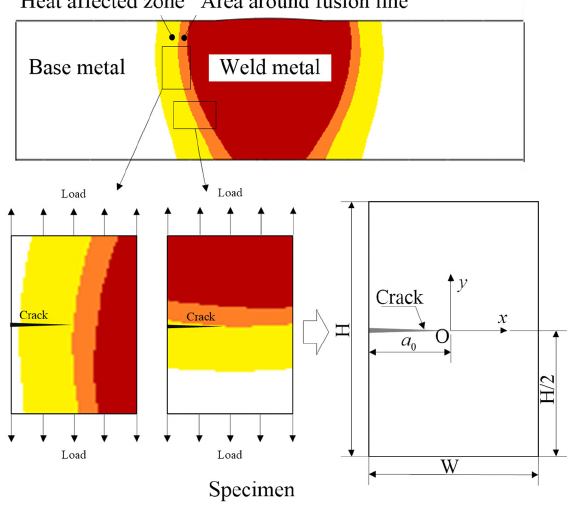
Figure 1. The dimensions of welded joints.